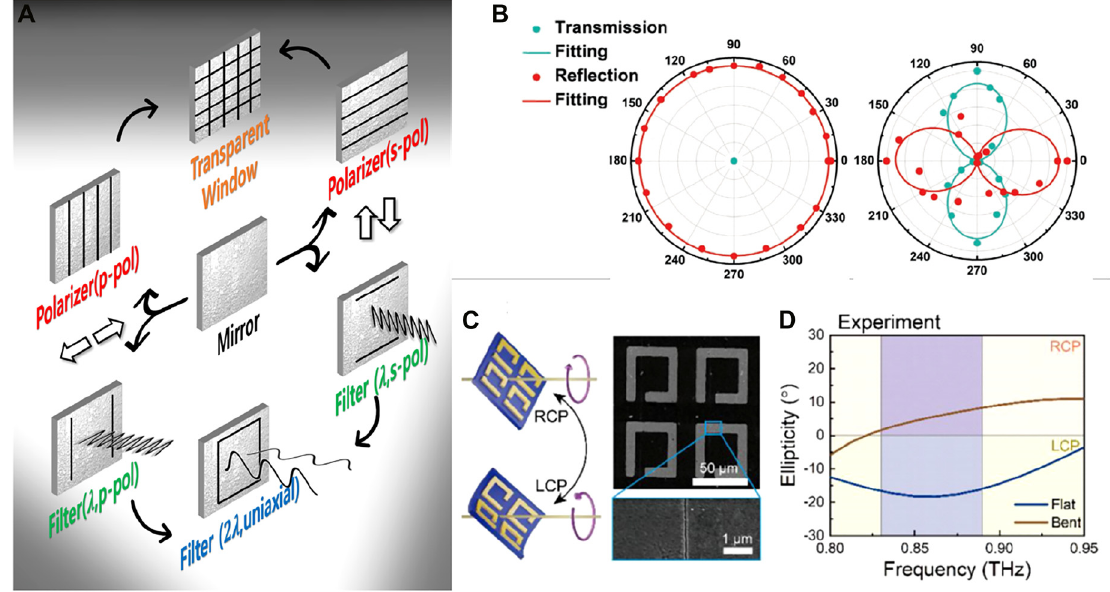
Figure 20: Full control of long wavelength radiations with zerogaps. (A) Various possible gap configurations and their respective optical functions. (B) Transformation from a mirror to a polarizer achieved in an arrayofclosableslits.(C)Splitringresonatorswithembeddedzerogapsexhibitingachangeintopologyuponopeningandclosingthegap.(D) Helicity switching with the topology-changing zerogaps. Reproduced with permission from [27] (B) [189], (C) and (D).